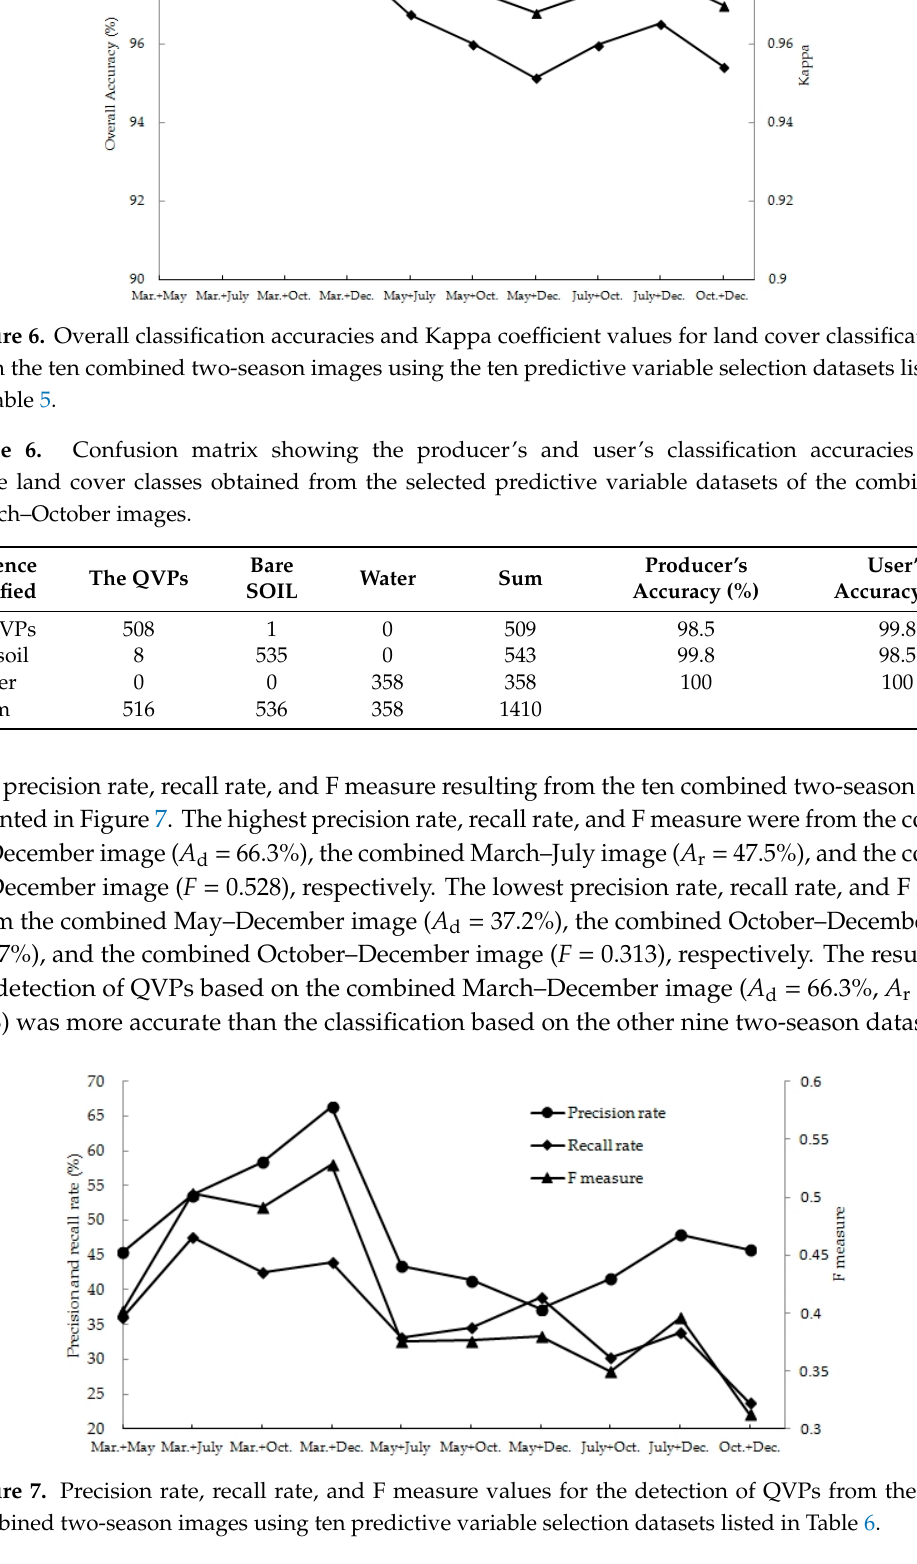
Figure 7. Precision rate, recall rate, and F measure values for the detection of QVPs from the ten combined two-season images using ten predictive variable selection datasets listed in Table 6.